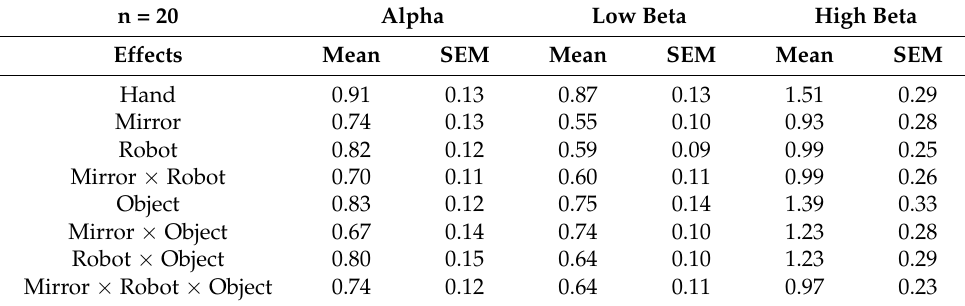
Table 4. Interhemispheric coherence sum in the onset >1 year group.